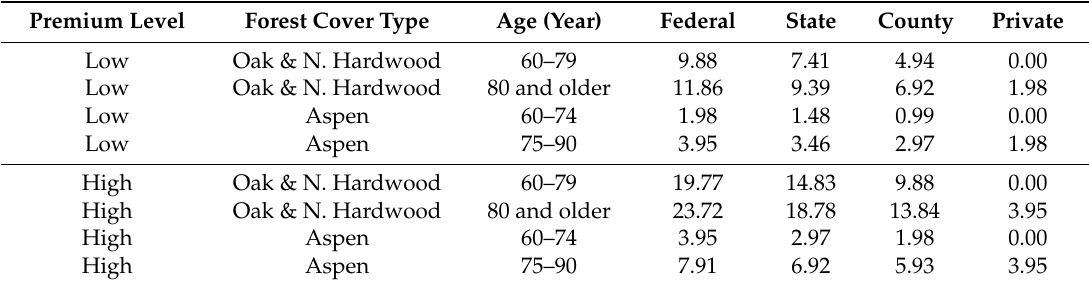
Table 2. Premiums considered for old forest of upland hardwoods based on forest cover type, stand age class, and forest ownership class